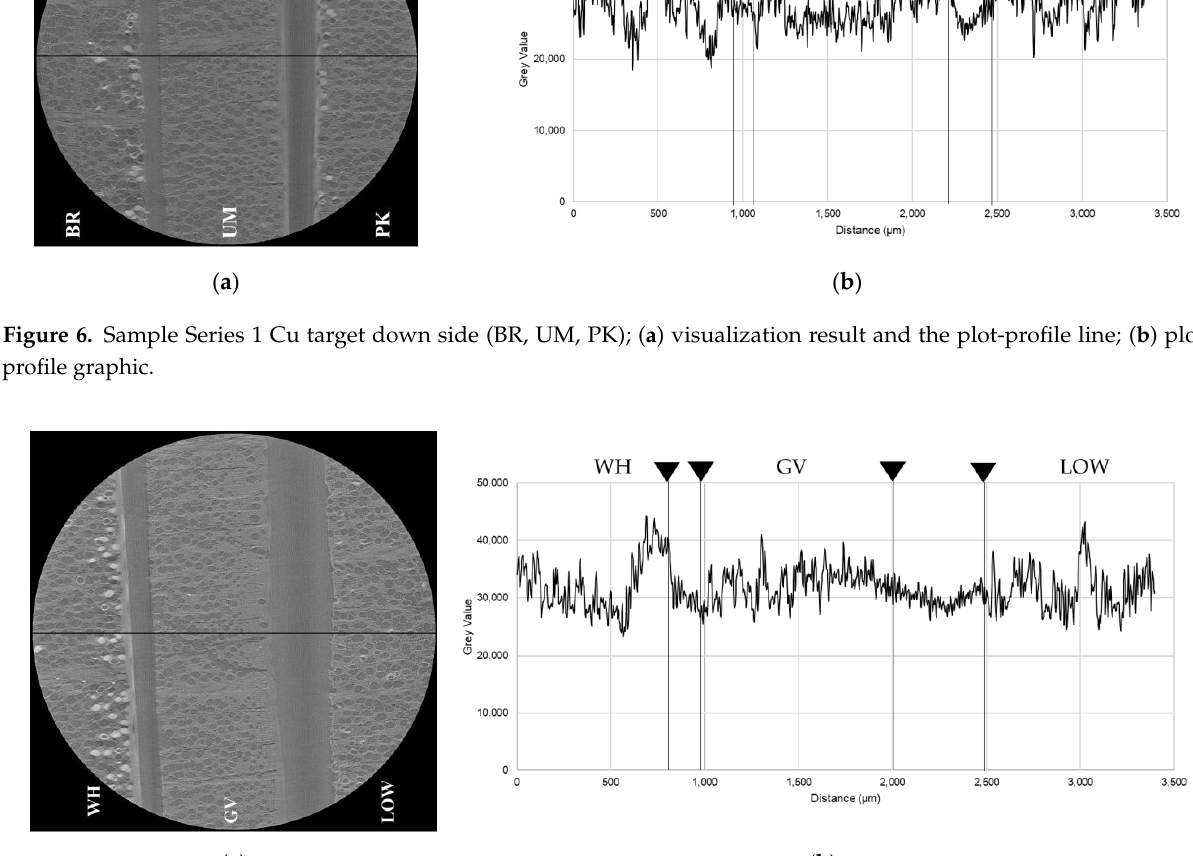
( b ) Figure 8. Sample Series 2 Cu target up side (MW, MV, LOO); ( a ) visualization result and the plot profile line; ( b ) plot profile graphic.